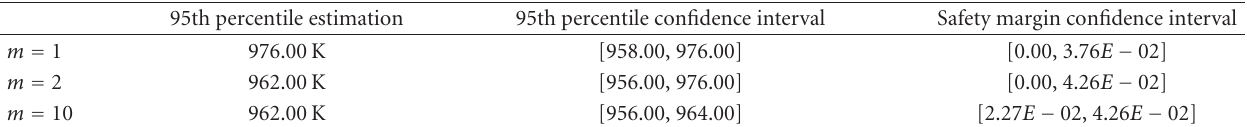
Table 4: Estimated 95th percentile, corresponding confidence interval, and safety margin confidence interval obtained by the bootstrap method with B =